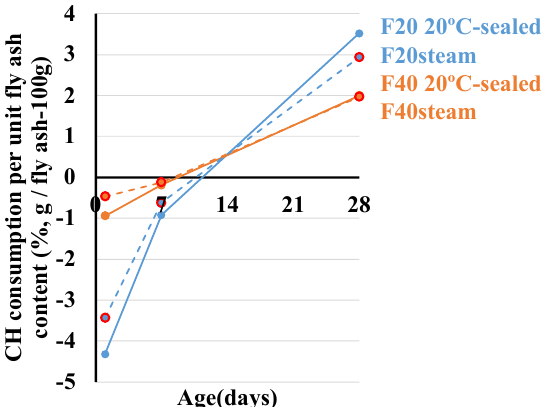
Figure 4. CH content with age. Figure 5. CH consumption per unit fly ash content with